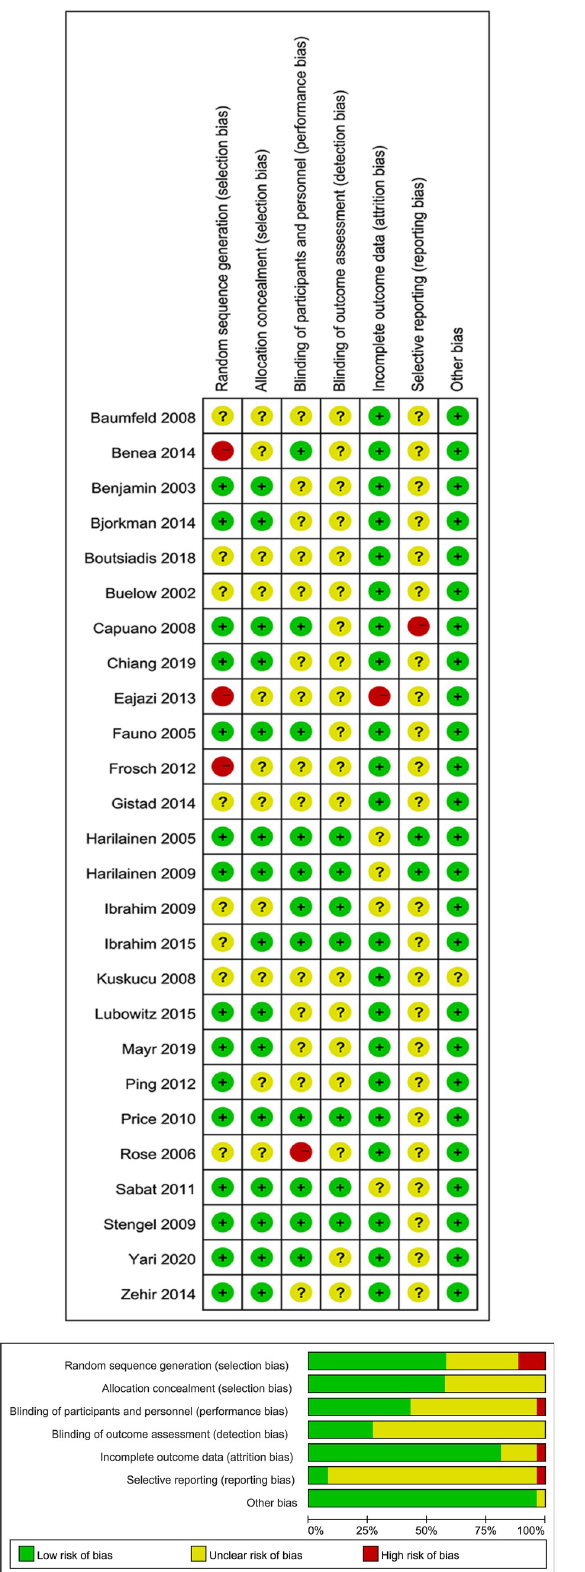
Fig 2. Risk of bias assessment for the included